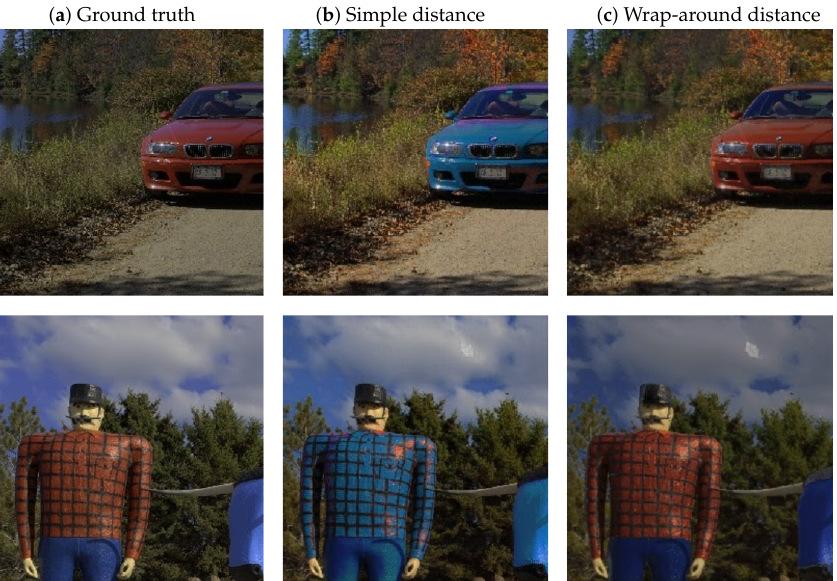
Figure 3. Comparison of simple distance loss (MAE) to wrap-around distance loss. All HDR images are tone-mapped in this paper.